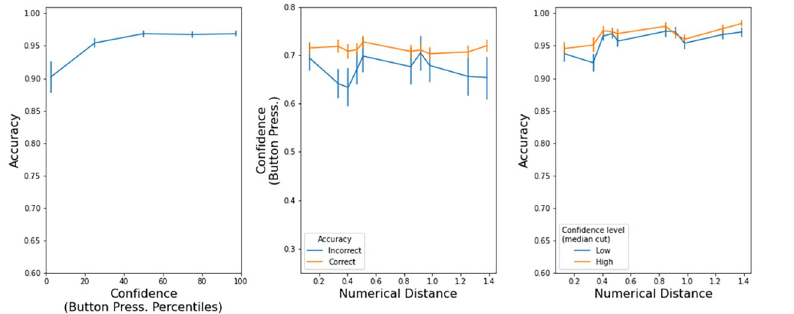
Fig 7. Confidence characteristics in button pressure (Exp. 2). Error bars are s.e.m.